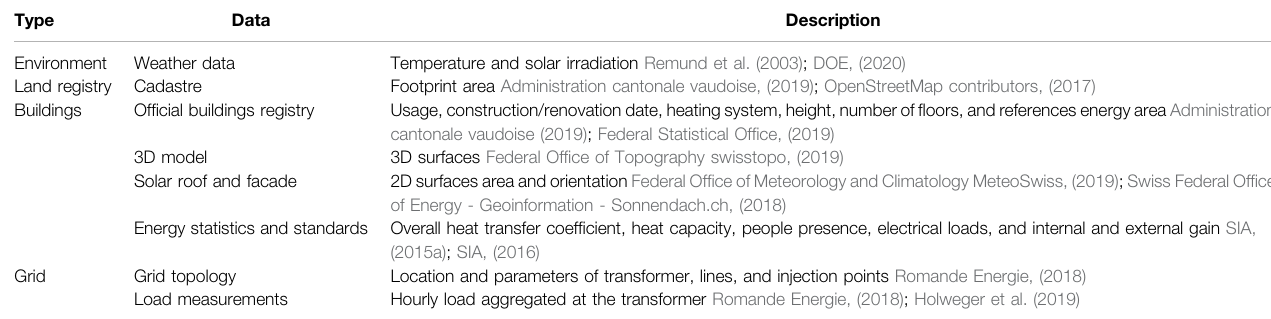
TABLE 2 | List of the necessary data